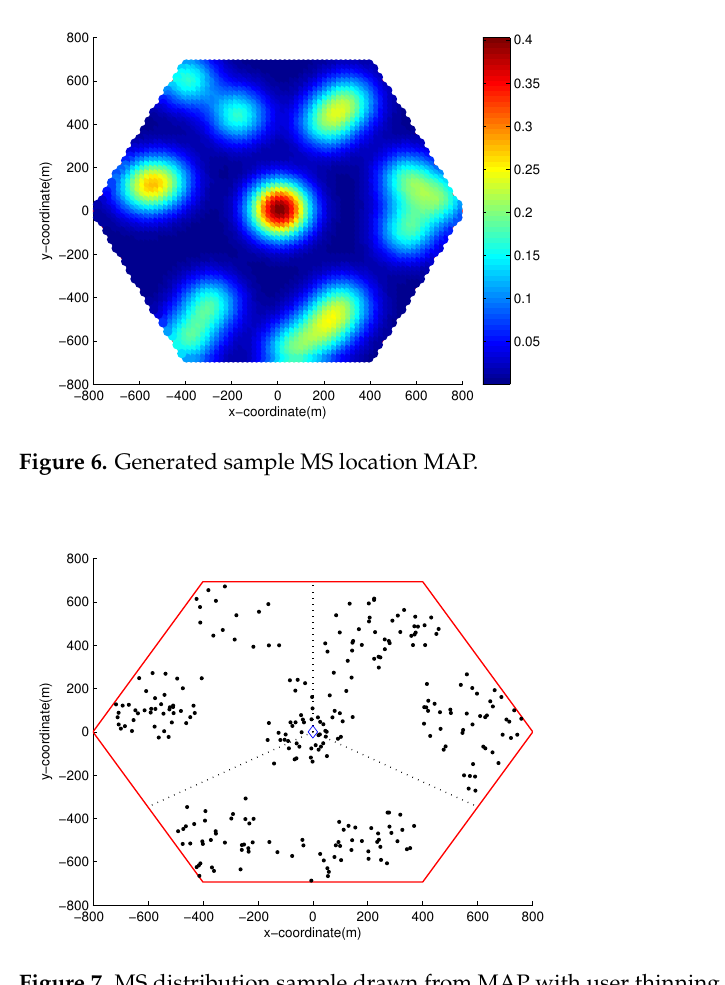
Figure 7. MS distribution sample drawn from MAP with user